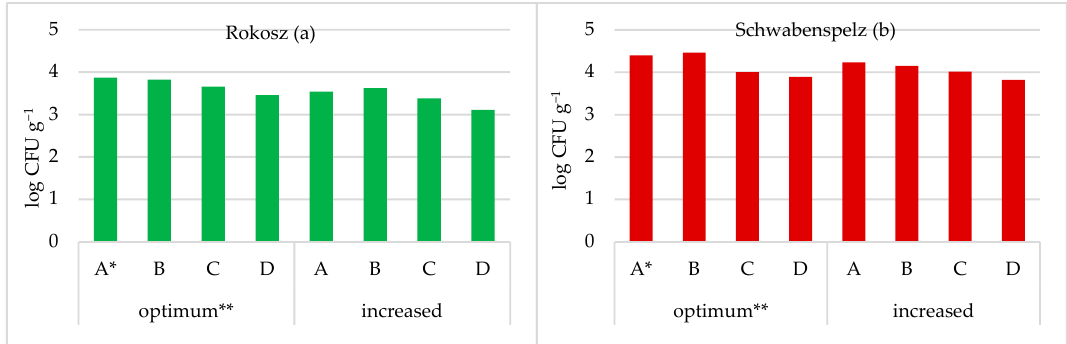
Figure 4. Total number of fungi in the grain of spelt wheat cv. “Rokosz” ( a ) and cv. “Schwabenspelz” ( b ) (mean for 2014–2015). Note: * crop protection methods, ** seeding density.